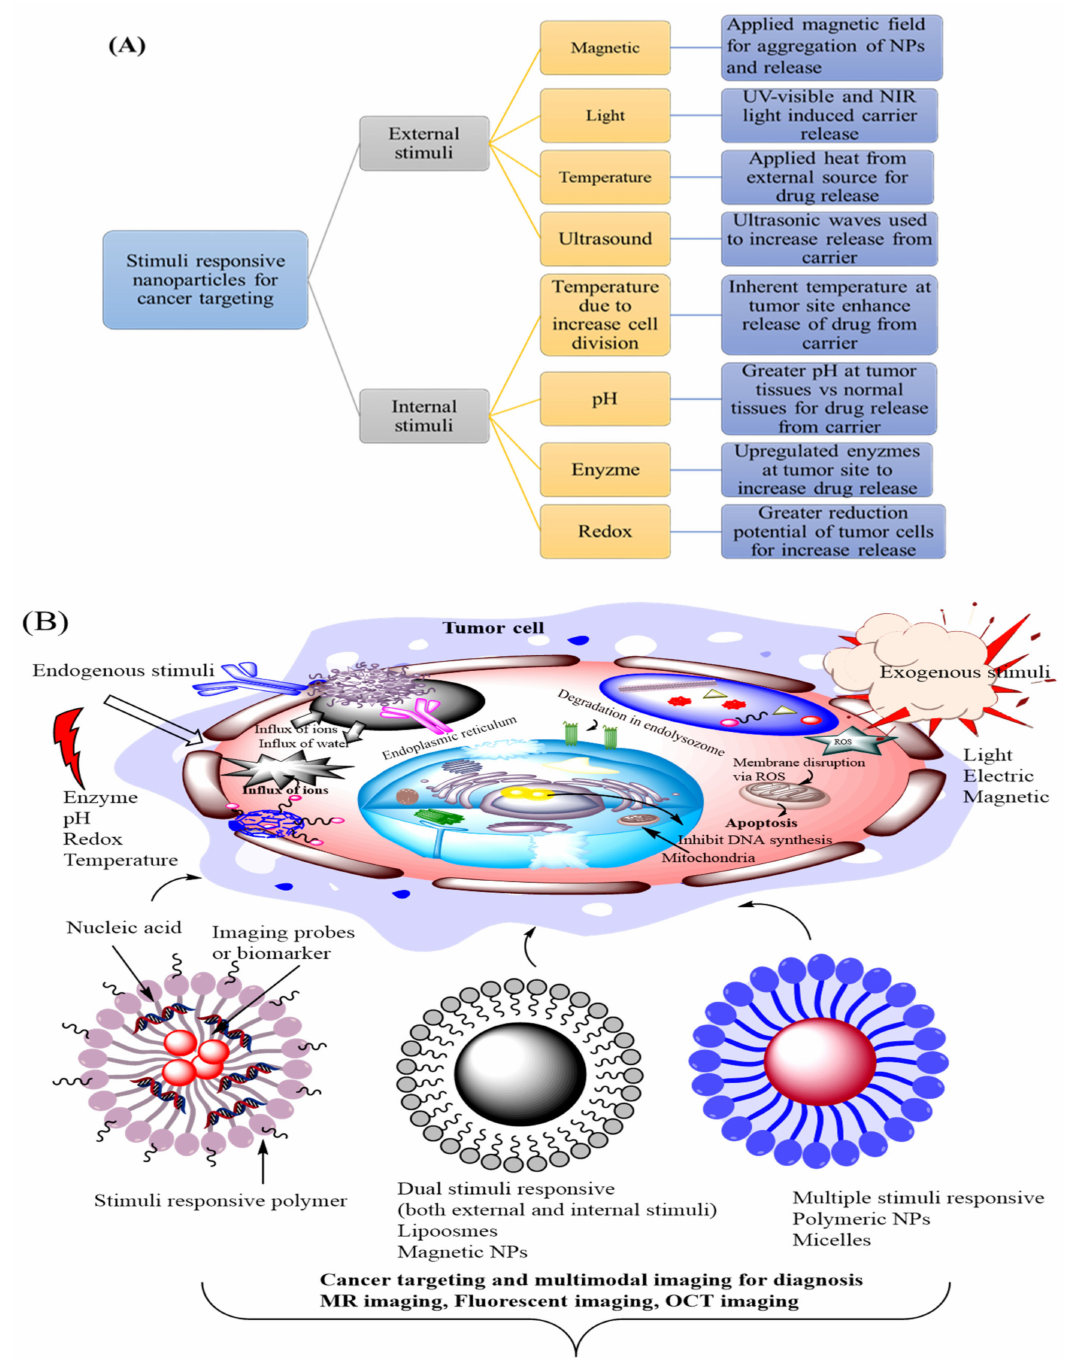
Figure 4. ( A ) Schematic representation of different types of exogenous and endogenous stimuli ( B ) Showed different types of stimuli responsive nanoparticle for cancer